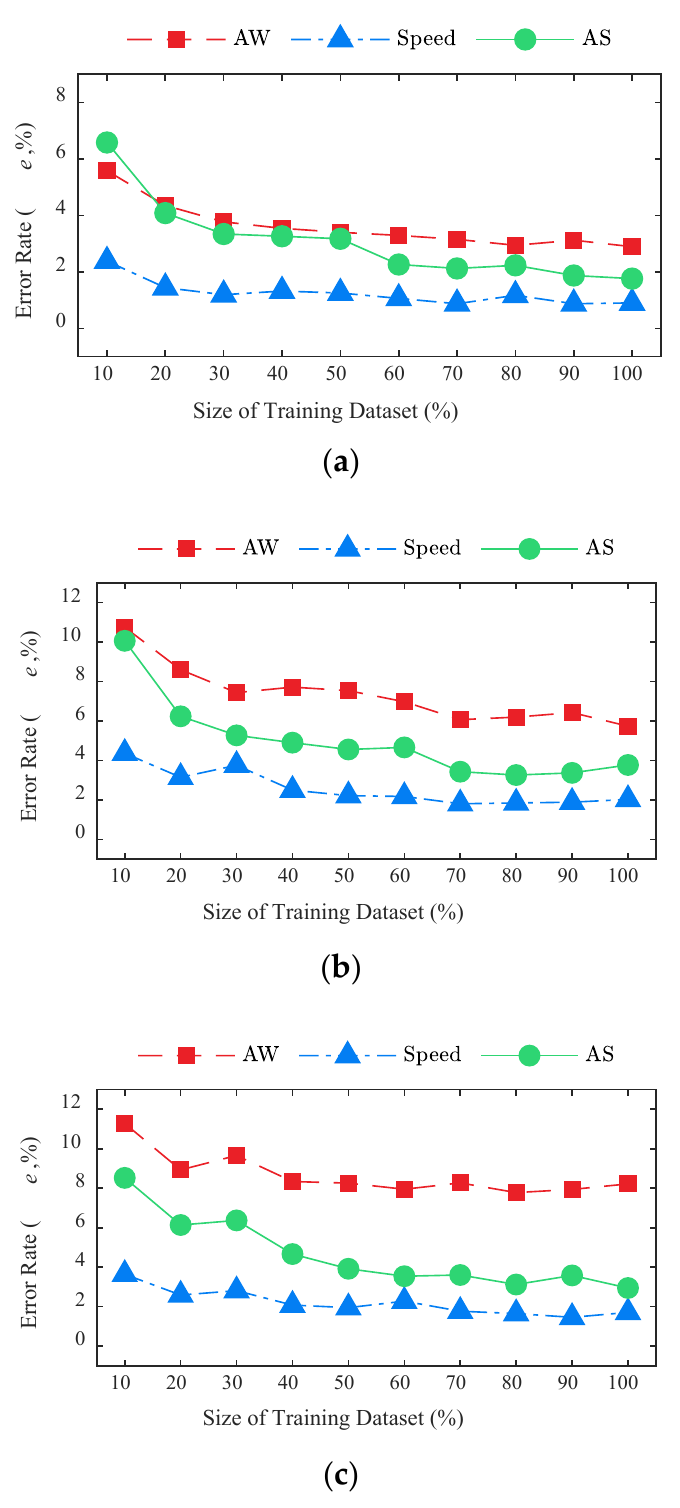
Figure 16. Effect of training data size on the BwimNet method’s identification performance: ( a ) 2-axle truck; ( b ) 3-axle truck; ( c ) 5-axle truck. AW, axle weight, AS, axle spacing.